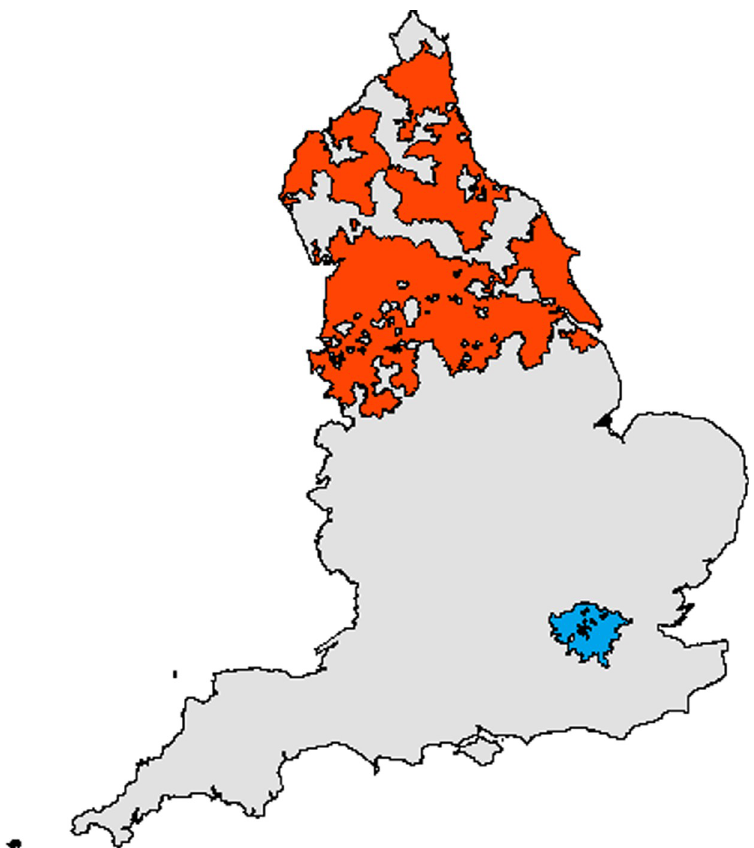
Fig 1. Map of England showing the intervention (London) and control (North of England) areas. Blue = London; red = North of England. This figure was created using a base map downloaded from https://osdatahub.os.uk/